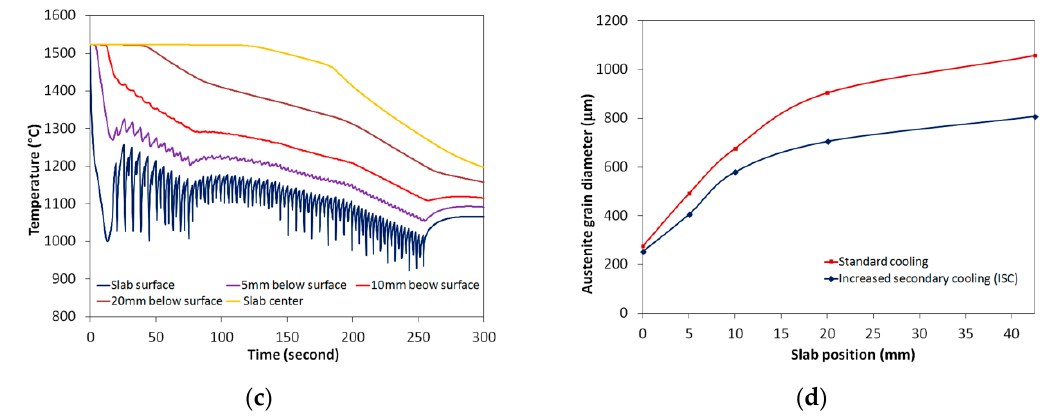
Figure 9. ( a ) the Algoma direct strip production complex (DSPC) model-predicted slab surface temperature using different secondary cooling set-ups; ( b ) the water loops configuration at Algoma DSPC; ( c ) the calculated 85mm slab temperature profile using increased secondary cooling; and ( d ) comparison of 85mm slab austenite grain sizes using standard cooling and increased secondary cooling.